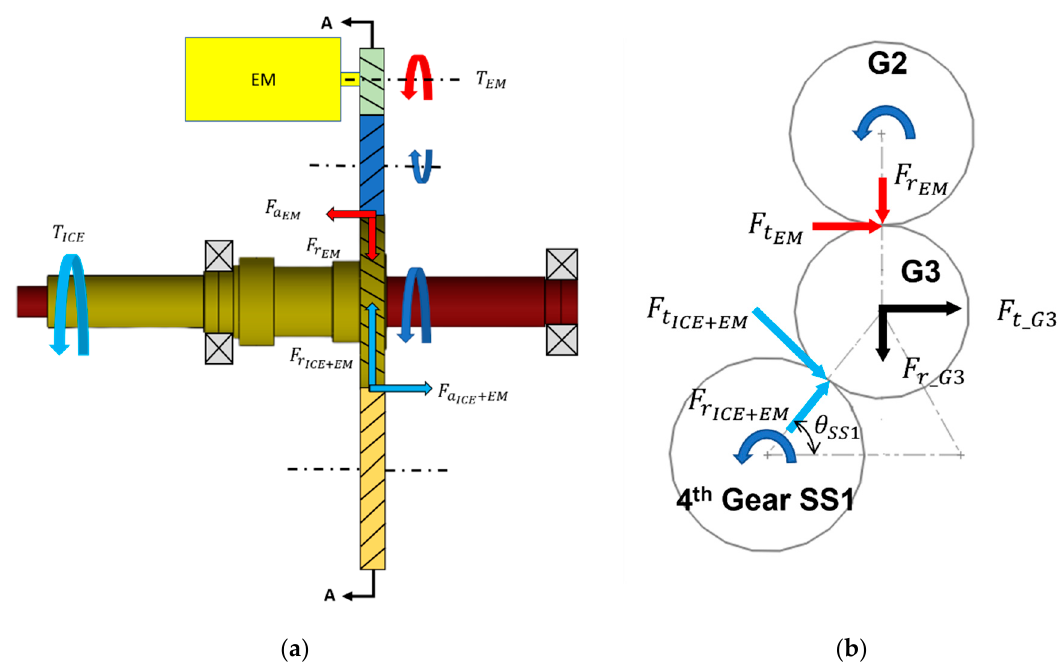
Figure 6. ICE +EM in 4th gear: ( a ) front view; ( b ) side view.